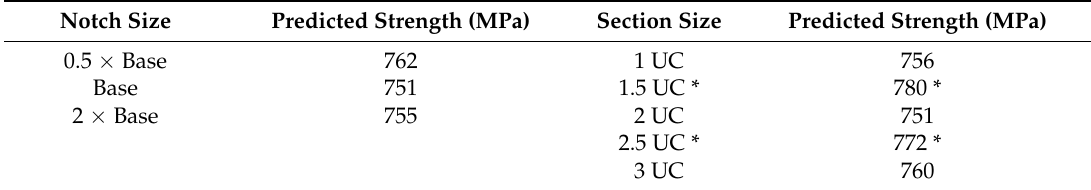
Table 7. The predicted strength of notched specimens with different geometrical characteristics. Notch